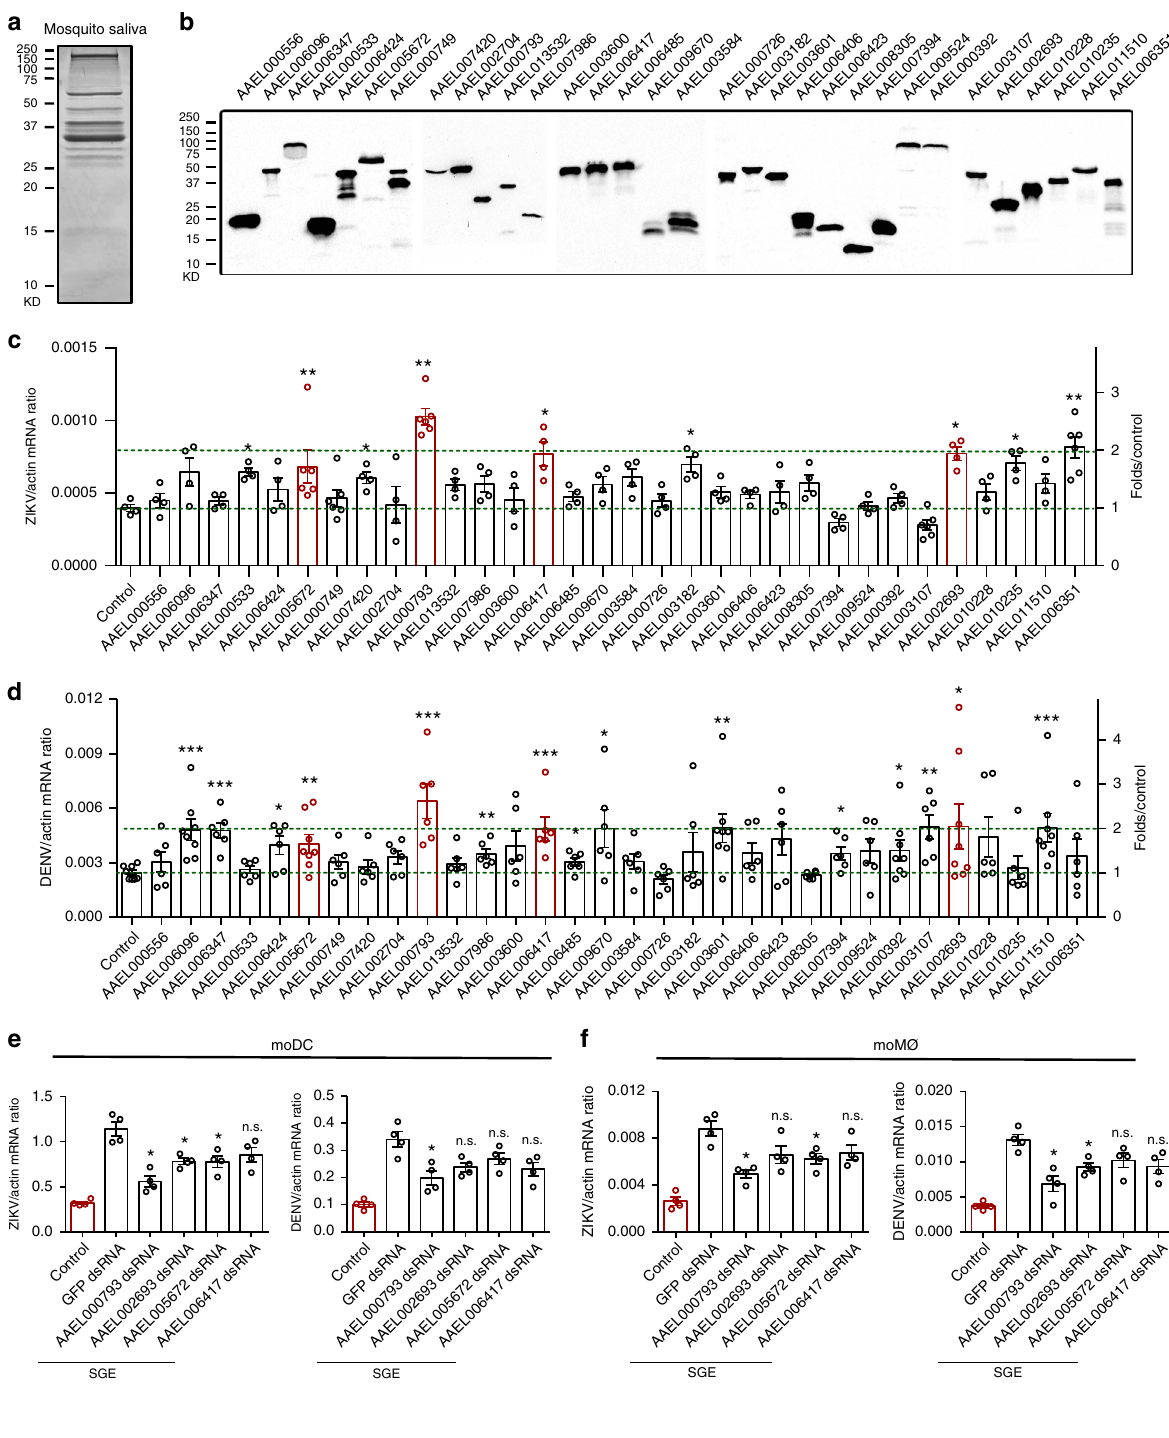
among human individuals, we next assessed the role of Aa VA-1 in fl avivirus infection of immune cells from different individual donors. Aa VA-1 universally enhanced both DENV (Supplementary Fig. 5A) and ZIKV (Supplementary Fig. 5B) infections in monocytes from several individuals. Taken together, Aa VA-1 is a mosquito salivary protein that promotes fl aviviral replication in human monocyte-lineage immune cells. Aa VA-1 facilitates fl aviviral transmission to mice . We next assessed the role of Aa VA-1 in fl aviviral transmission in a